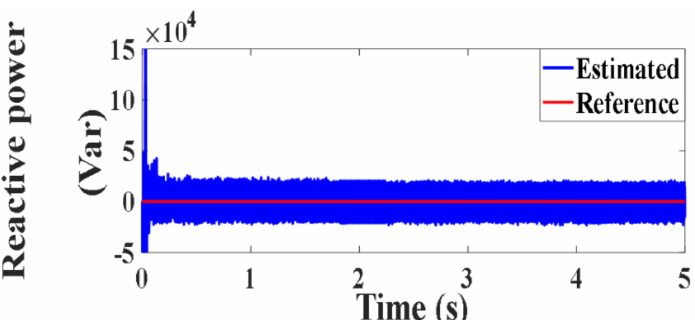
Figure 25. Reactive power under MPCC (var).